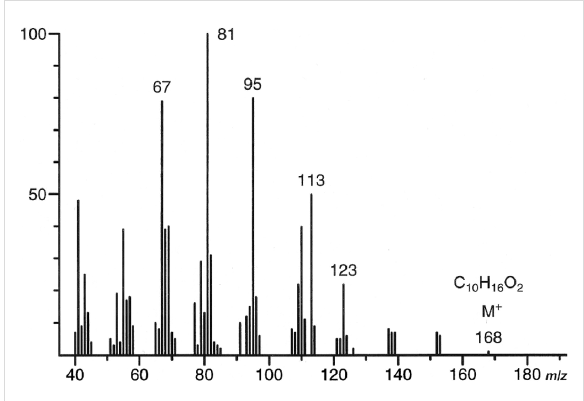
Figure 2: 70 eV EI-mass spectrum of the iridoid X , a component of the volatile secretions of the parasitoid wasp Alloxysta victrix .